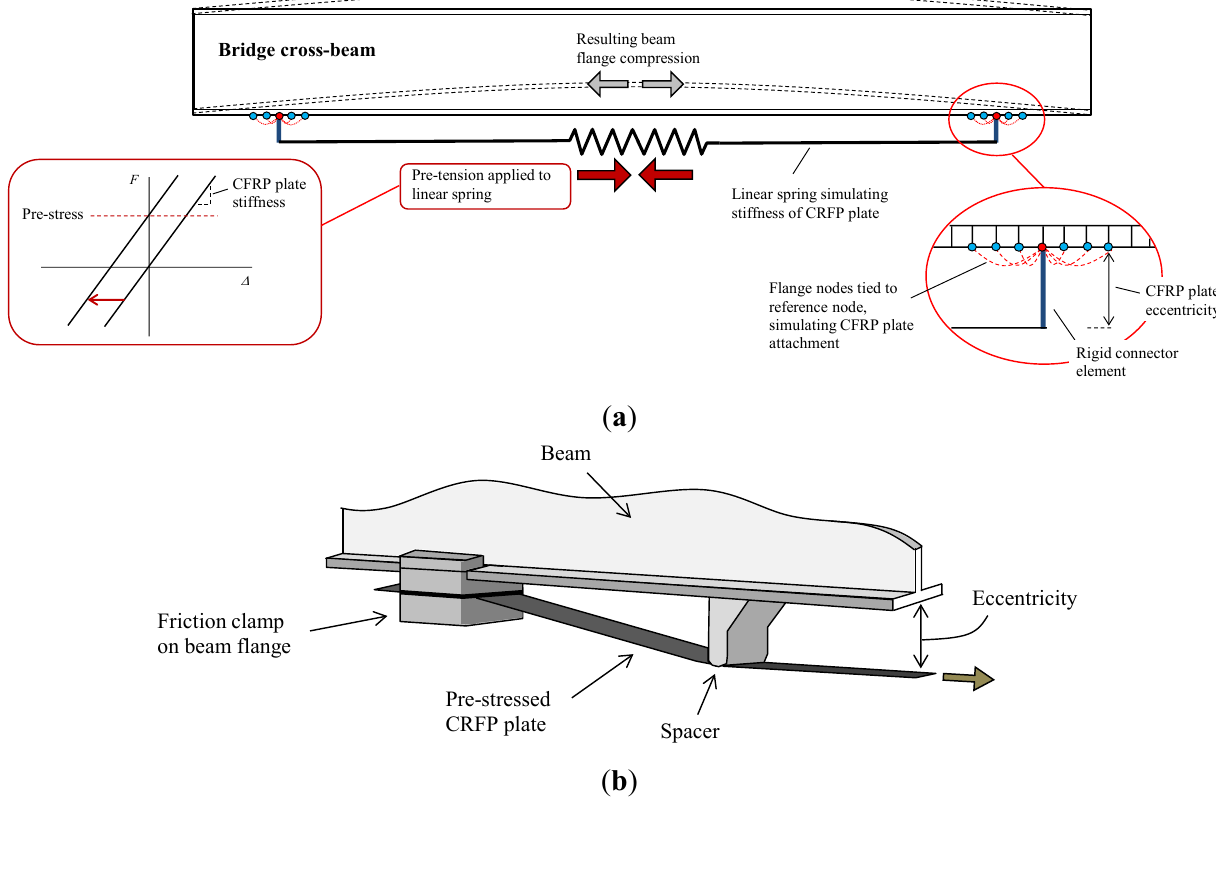
Figure 8. ( a ) Modeling of the un-bonded CFRP post-tensioning system; and (b ) Scheme of the un-bonded CFRP post-tensioning